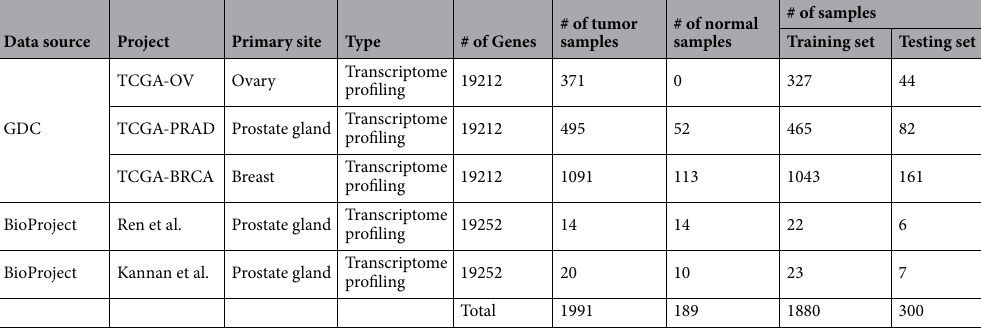
Table 1. Data description and distribution of samples across training and testing.